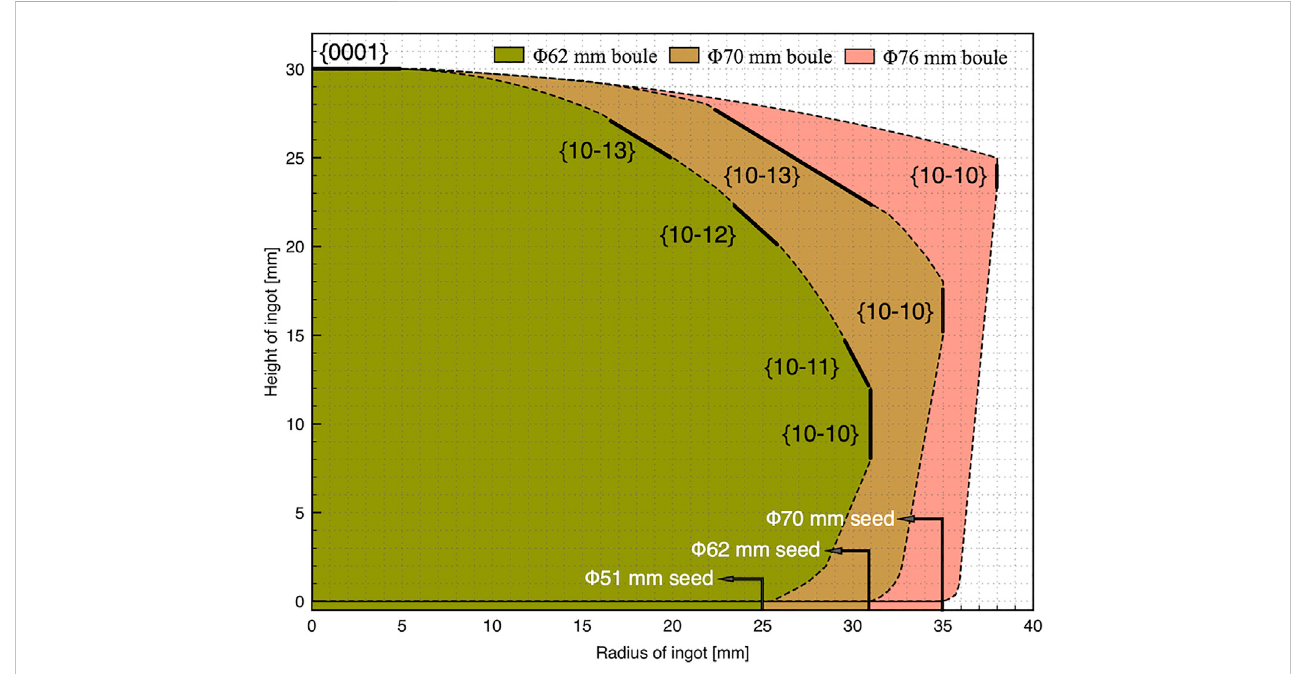
FIGURE 3 Schematic diagram of the AlN crystal shape evolution and growth habit with different diameters.